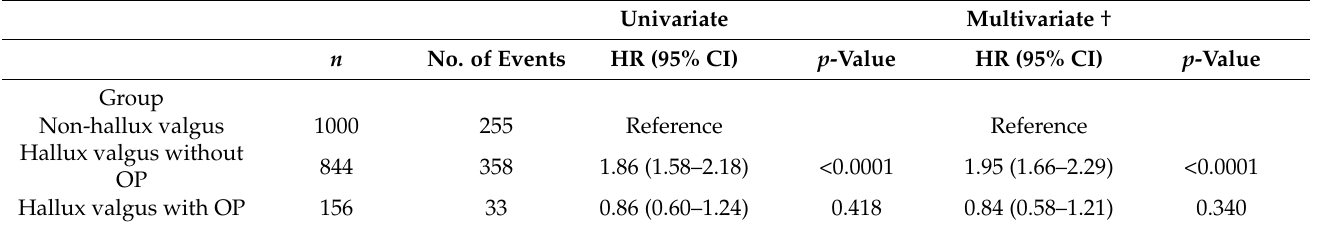
Table A2. Cox proportional hazard model analysis for risk of spinal degeneration in the hallux valgus group with and without operation.